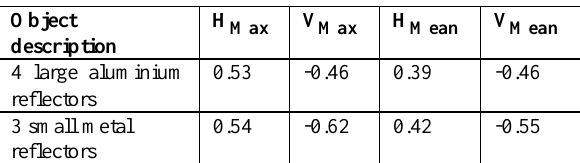
Figure 10. Residuals for 4 large and 3 small reflectors